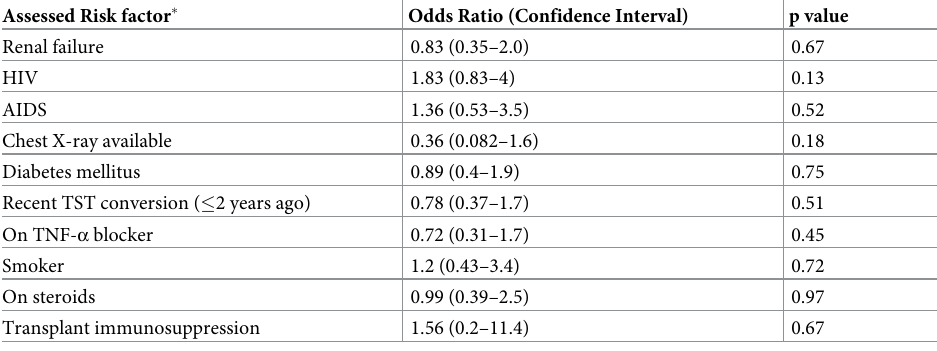
Table 4. Logistic regression analysis of relating probability of completion of treatment to assessment of selected individual TB progression risk